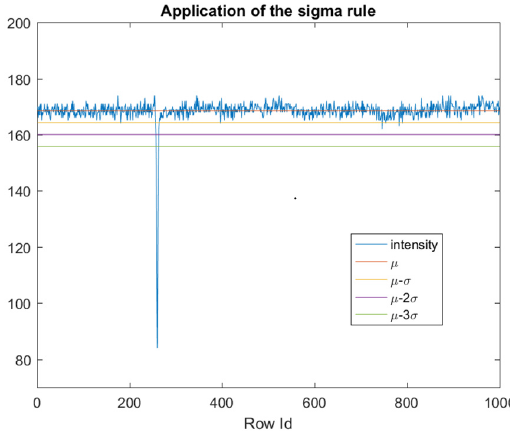
Figure 7. Application of sigma rule on a column that includes a blob defect. The mean of the luminous intensity of column b of Figure 5 is represented by line µ , while σ is the related standard deviation. Lines µ - σ , µ -2 σ , µ -3 σ , represent thresholds equal to µ minus 1, 2, 3 times σ ( k C ).